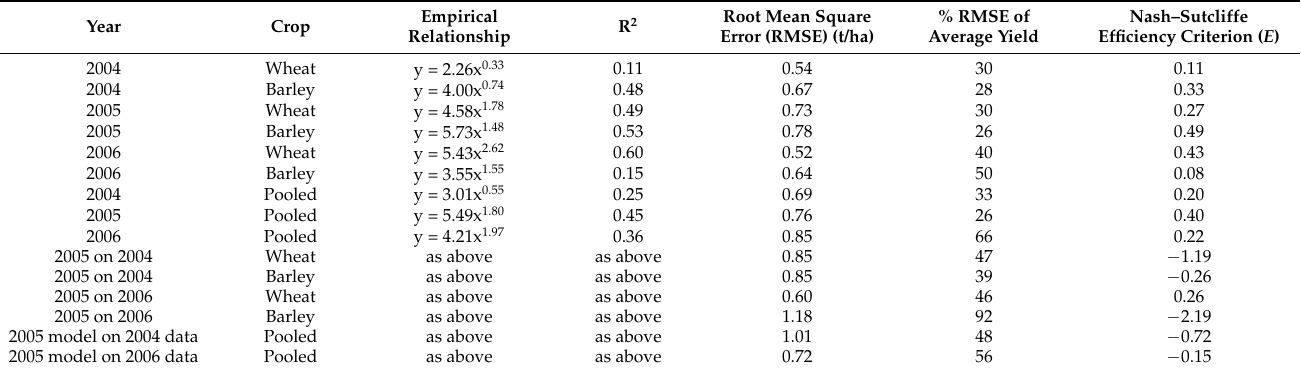
Table 3. Power empirical relationships, R2 and efficiency criteria (root mean square error (RMSE), % of RMSE of average yield and the Nash – Sutcliffe Efficiency Criterion ( E )) for the annual wheat and barley and the 2005 model for the state-wide analysis in 2004, 2005 and 2006.